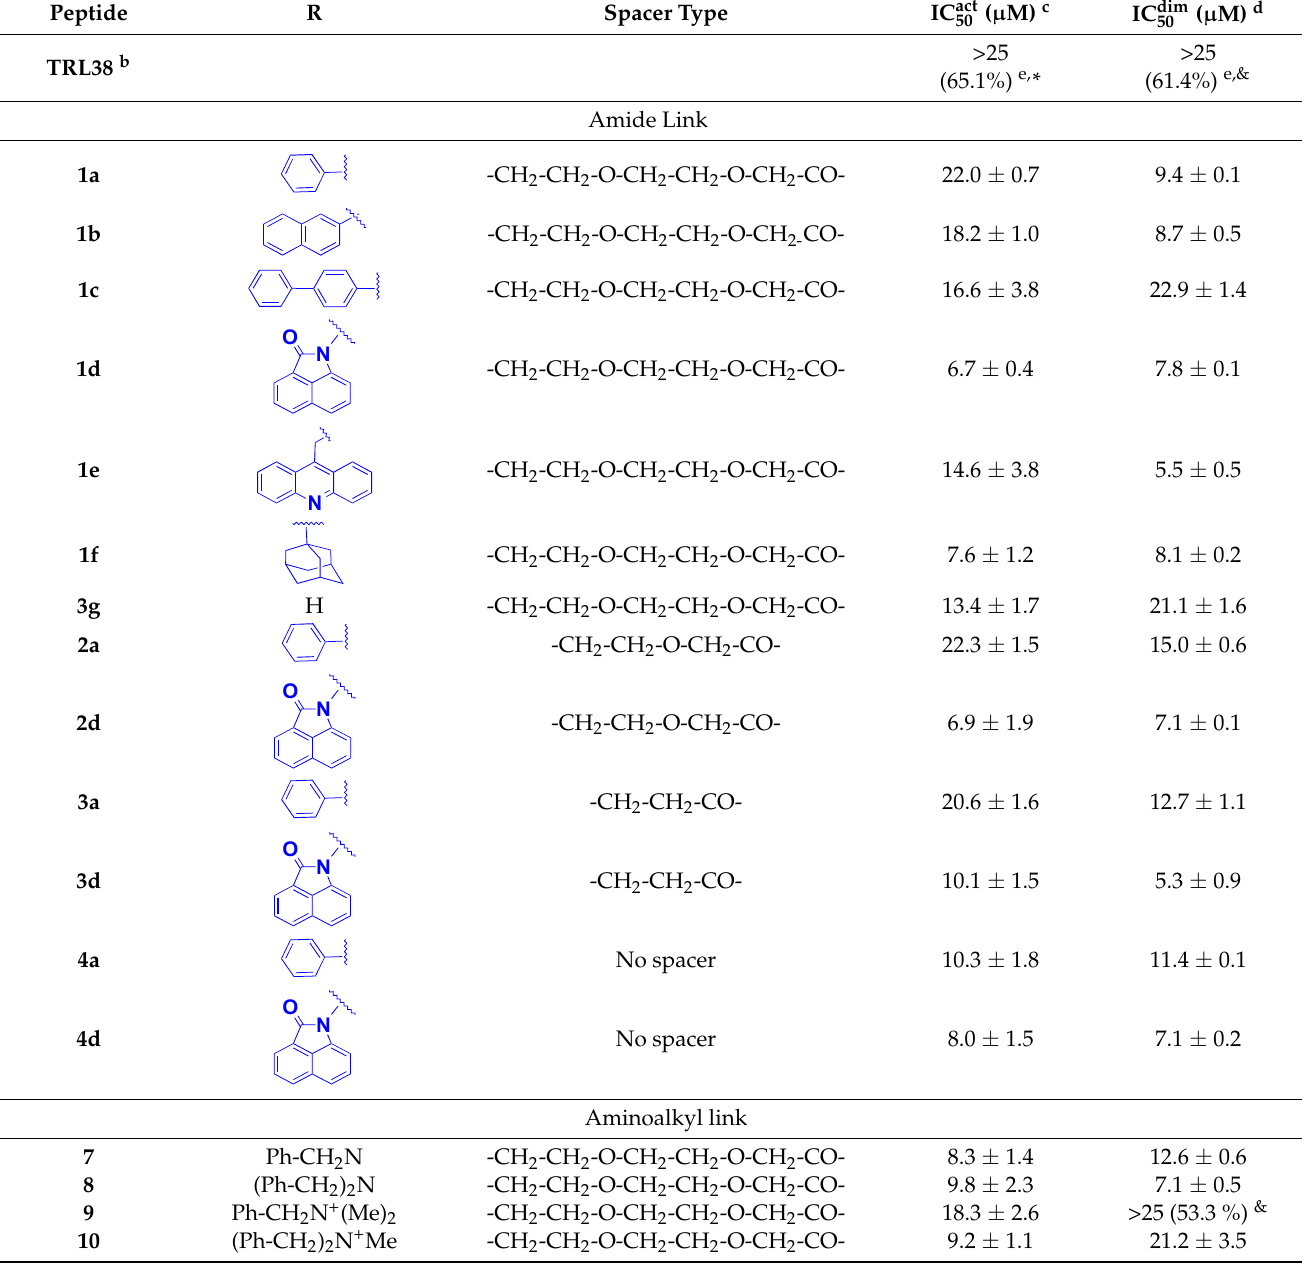
Table 1. Half-maximal inhibitory concentration (IC 50 ) ± standard error (SE) values for TRL38 conjugates in the Li TryR oxidoreductase activity and dimer quantitation assays a .